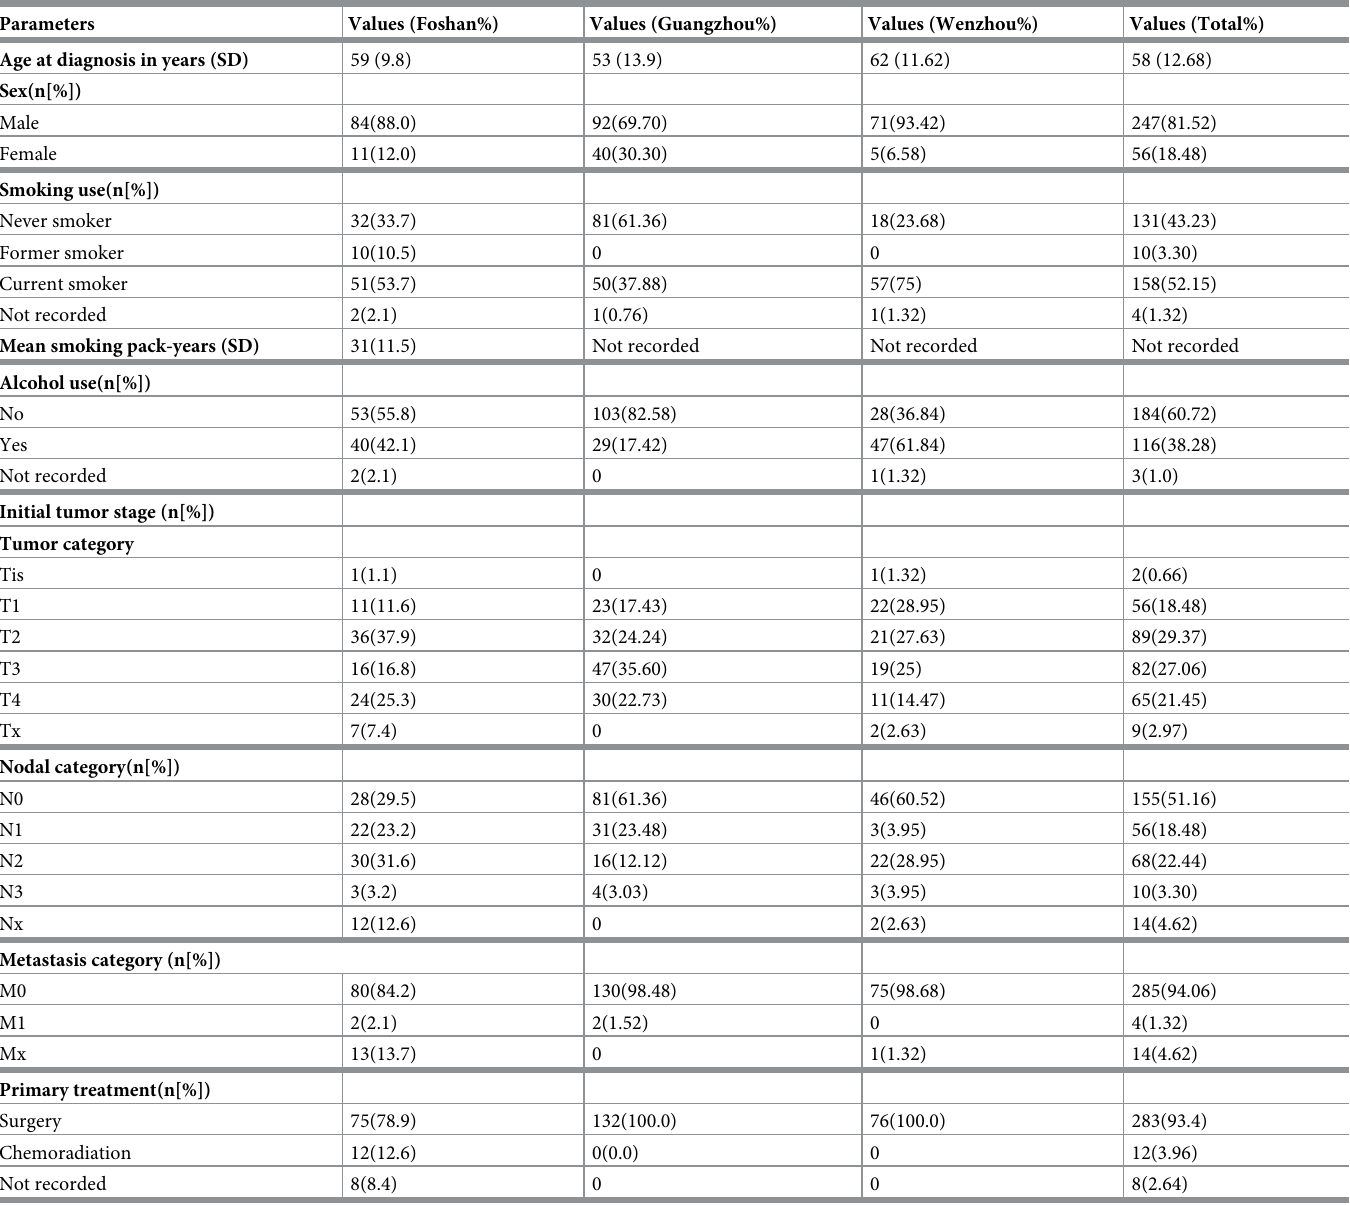
Table 1. Patients’ HNSCC information from three